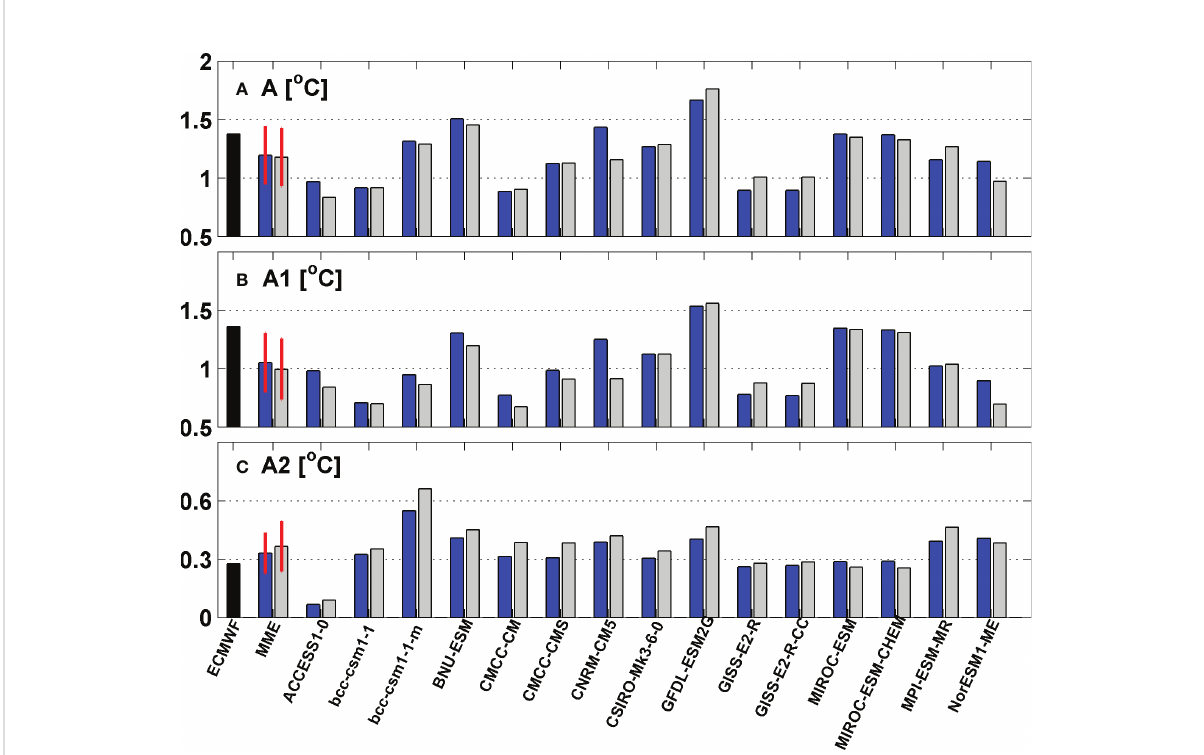
FIGURE 4 The amplitude (°C) of (A) SSTAC, and its (B) annual and (C) semi-annual components based on ECMWF reanalysis dataset (black bars), MME and each of 15 models in the historical period (blue bars) and RCP4.5 scenario (grey bars).Red lines represent the inter-model standard